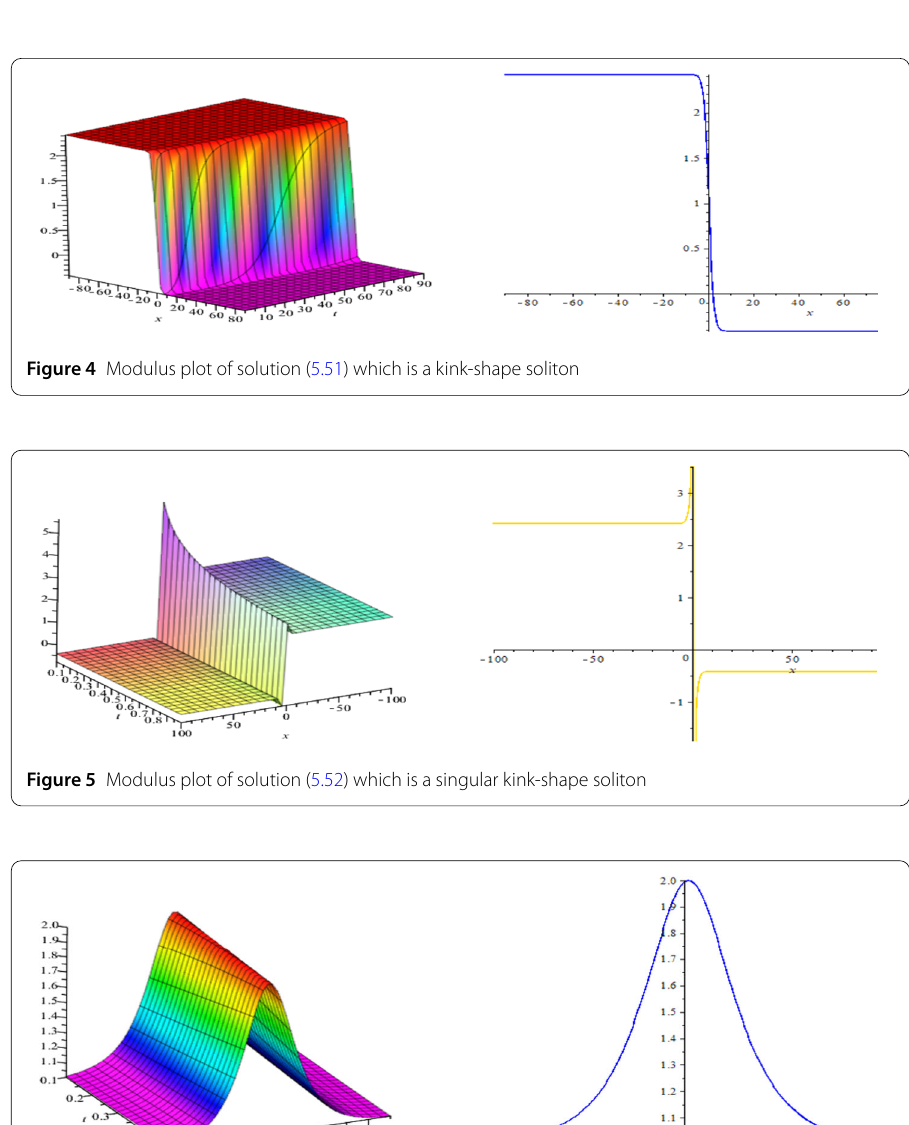
rived, which confirm the correctness and validity of the general solutions and the